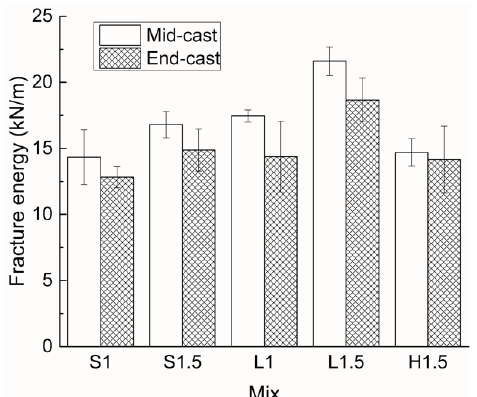
Figure 8. Fracture energies of all UHPCs with two different casting positions.